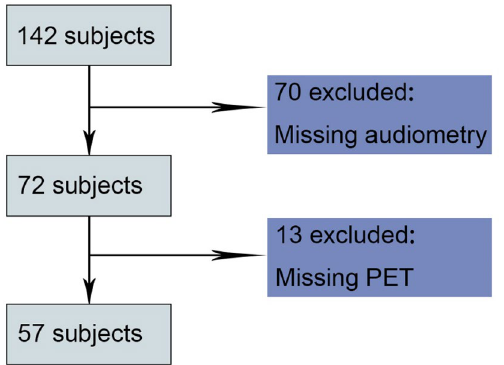
Figure 1. Diagram showing criteria to include and exclude participants. PET, positron emission tomography.